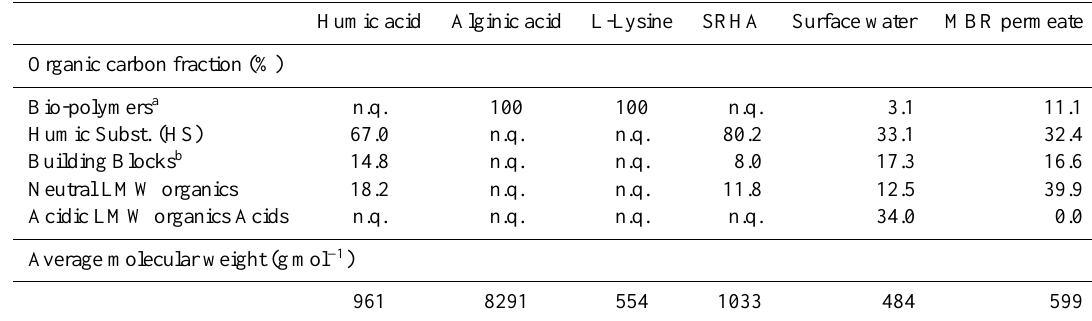
Table 3. Characterisation of the feed waters by LC-OCD.